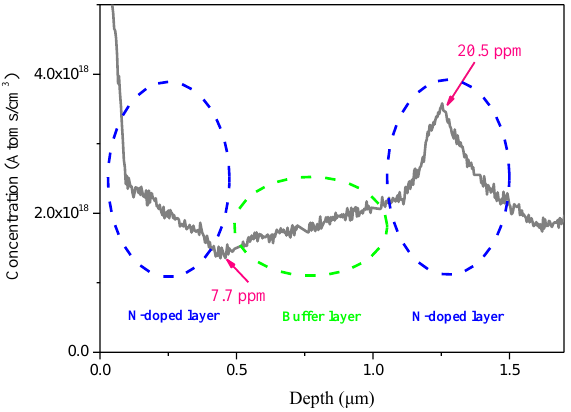
Figure 8. Secondary ion mass spectroscopy (SIMS) profile of the thin nitrogen-doped multilayers of sample 2.